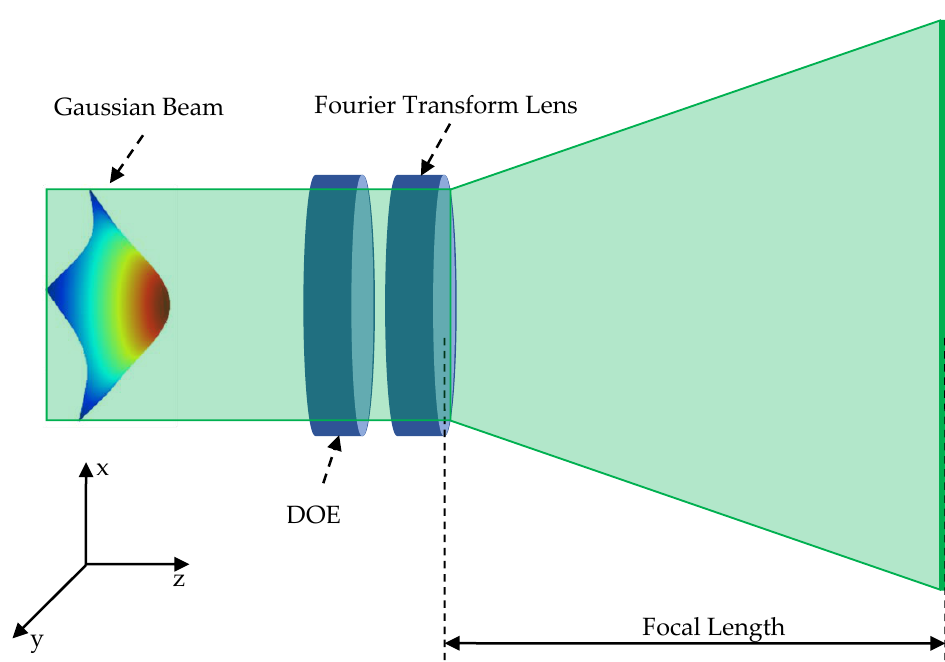
Figure 2. Schematic diagram of the laser sheet optical system.